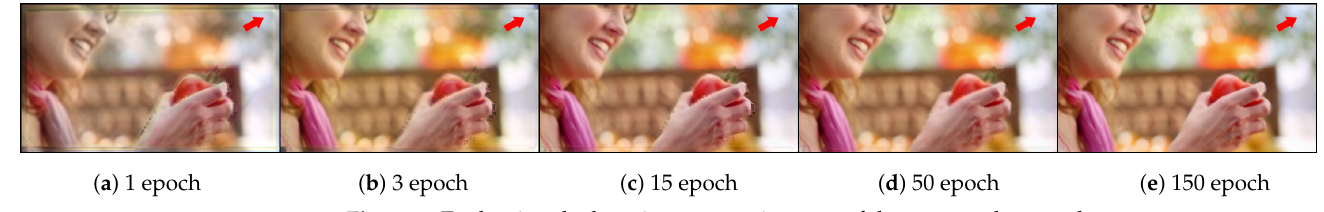
Figure 6. Evaluating the learning appropriateness of the proposed